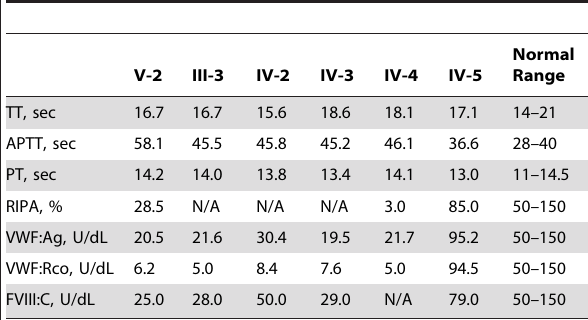
Table 1. Main laboratory findings of the patient and family